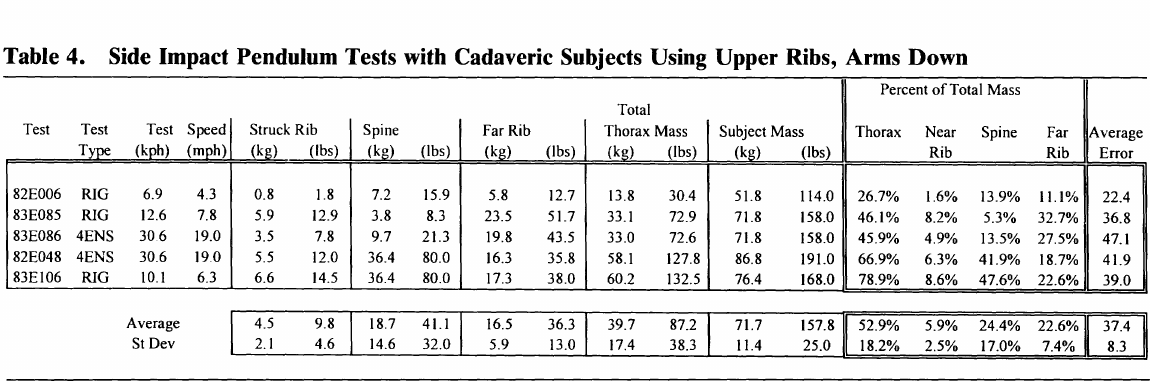
Table 4. Side Impact Pendulum Tests with Cadaveric Subjects Using Upper Ribs, Arms Down Test Test